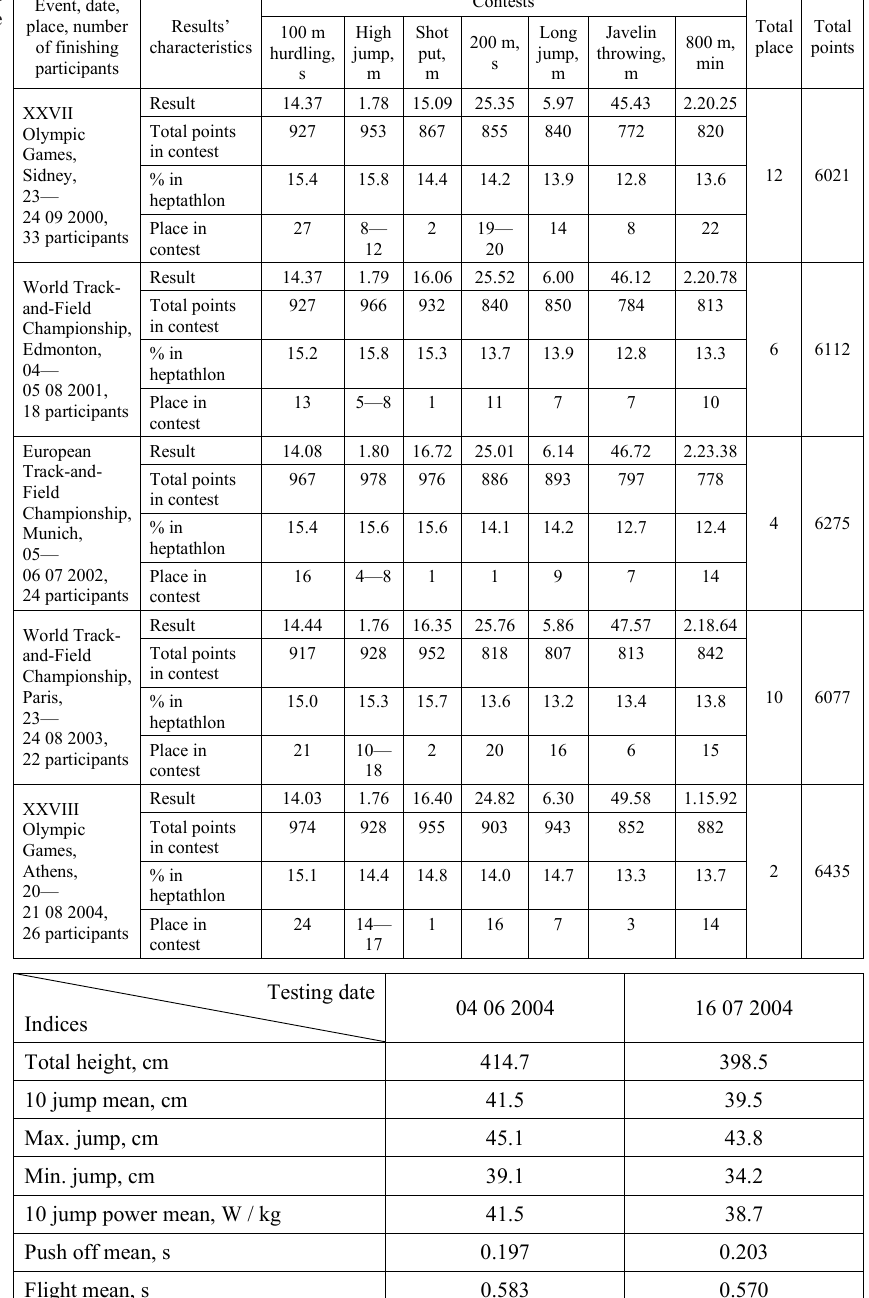
Table 1. Sports results’ dynamics of highly-skilled heptathlon athlete A. S. in 2000—2004